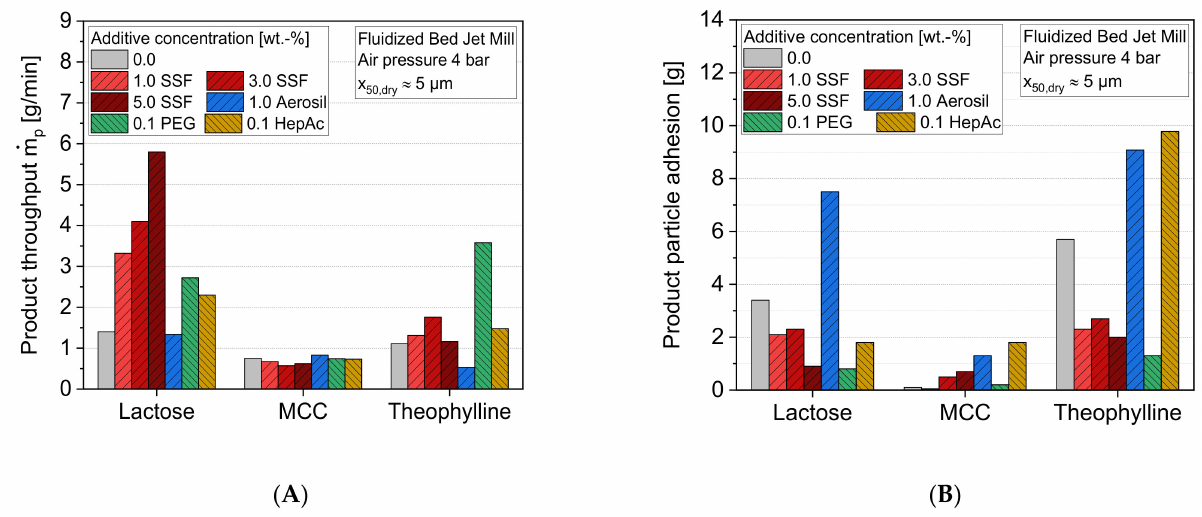
. m p , and ( B ) product particle